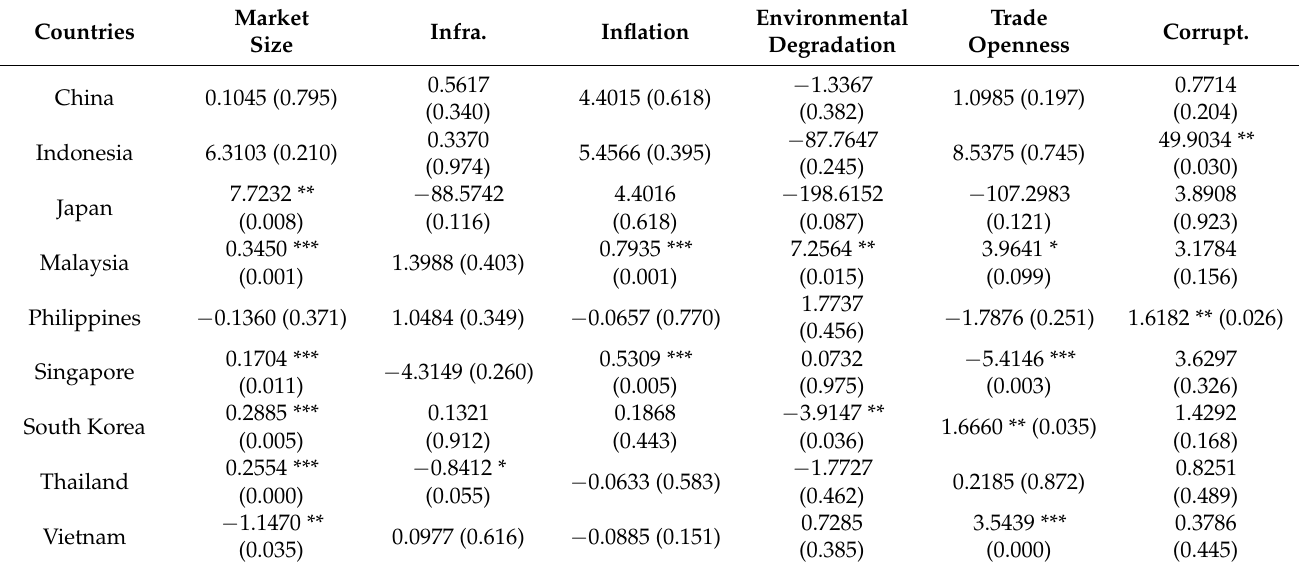
Table 8. Short-run country-specific